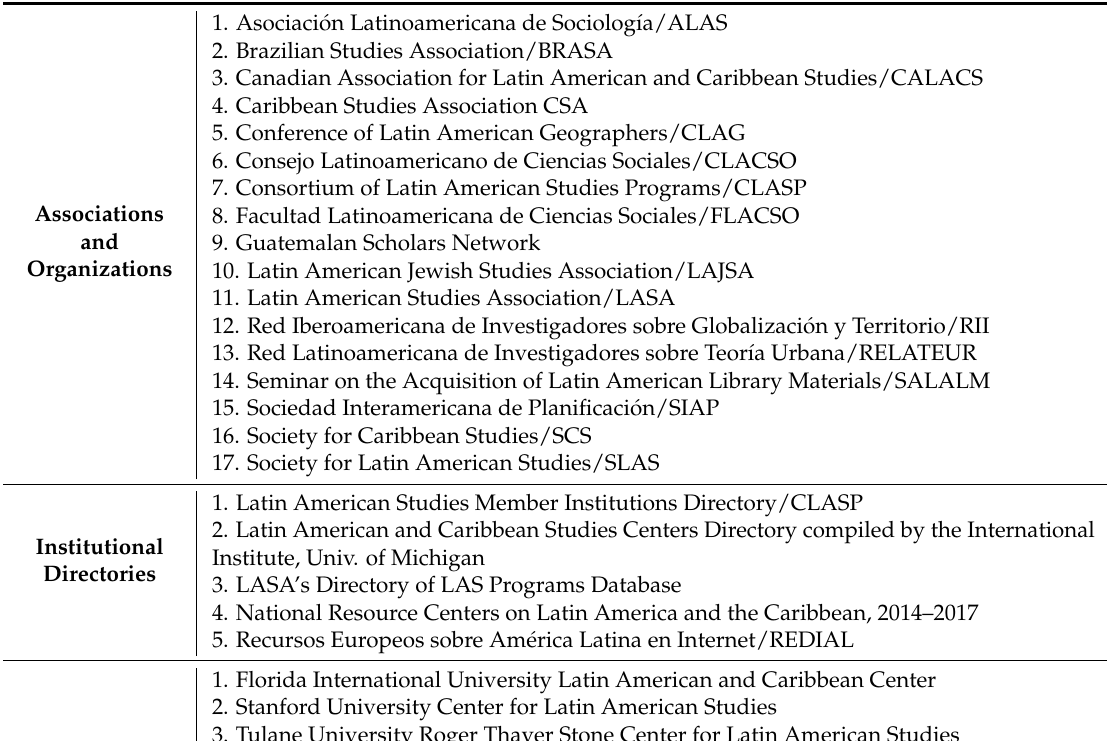
Table 1. Academic institutions with Latin American investigative frame.